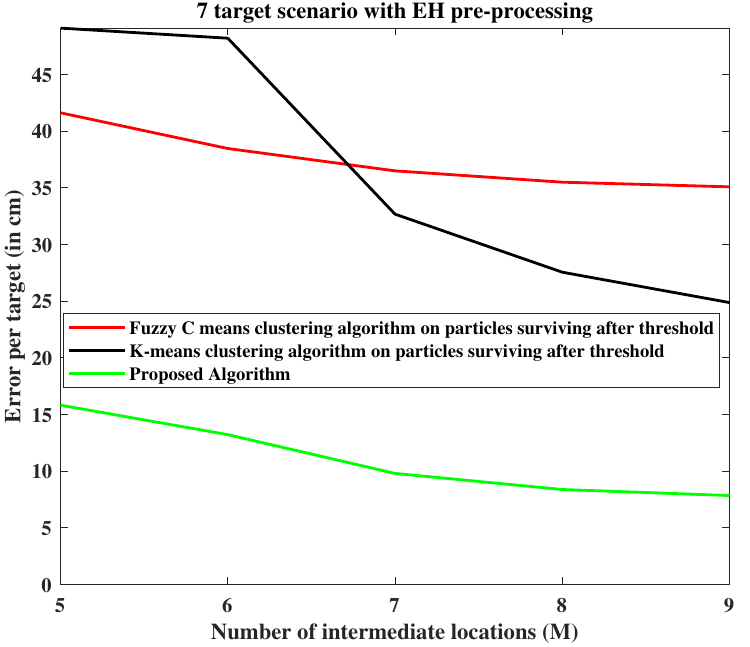
Figure 11. Performance comparison with different number of intermediate locations for σ =